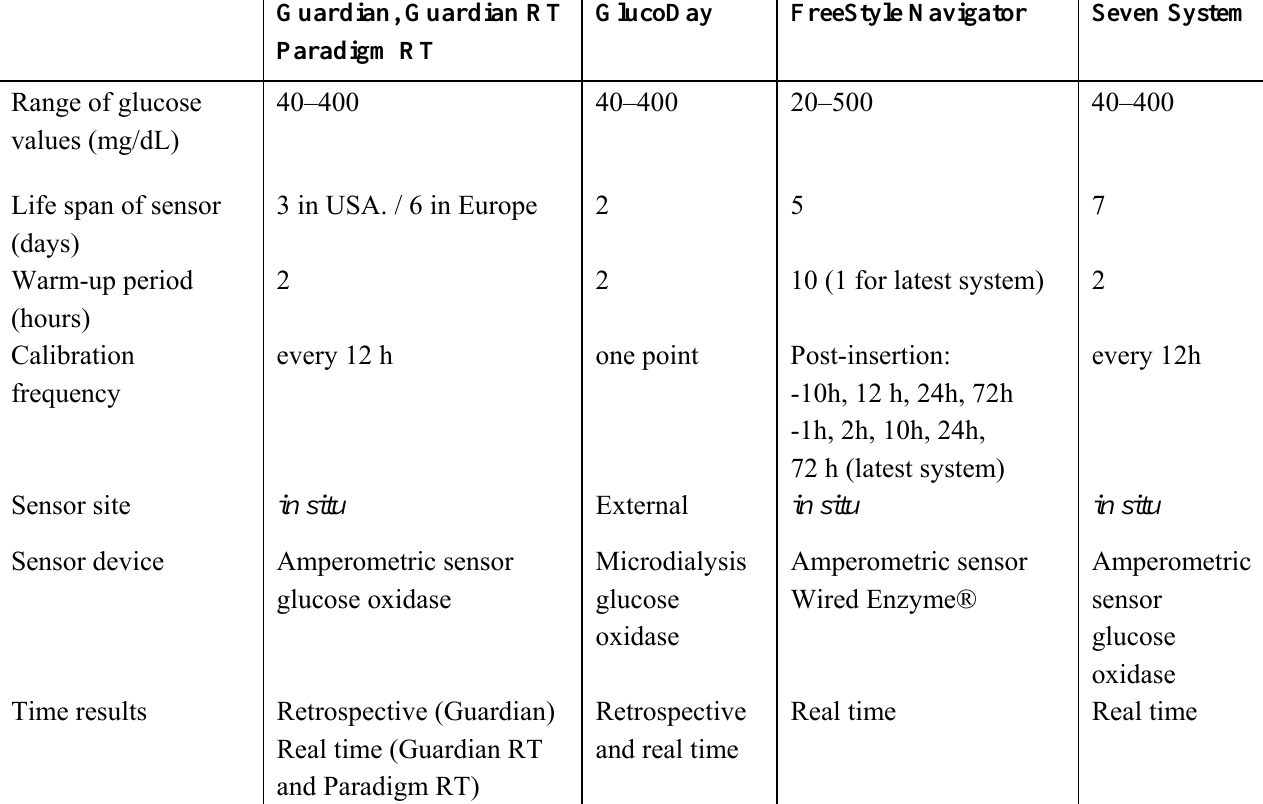
Table 1. Main features of the currently available CGMS